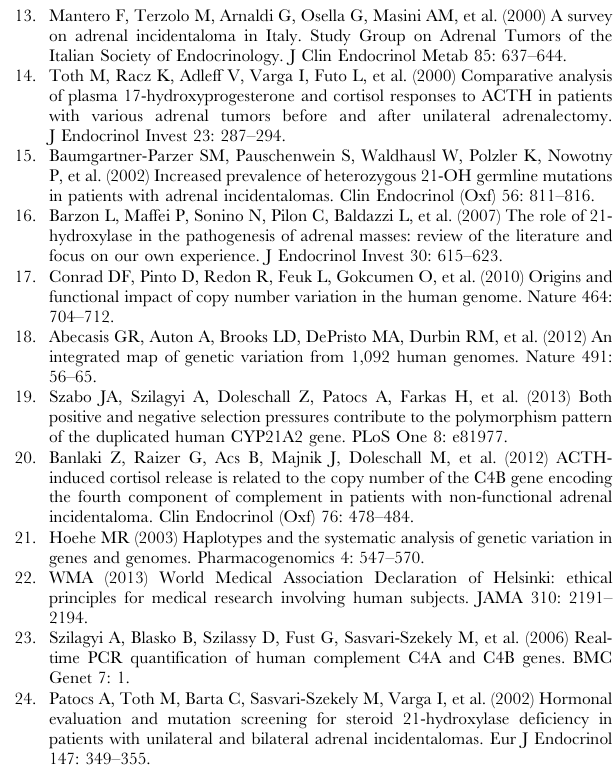
Figure S1 Linkage disequilibrium (LD) map of dimor- phic polymorphisms along the intron 2 and the 5 9 -end of exon 3 of the CYP21A2 gene in subjects with non- functional adrenal incidentaloma. The polymorphisms are numbered from the start of the CYP21A2 coding region in the sequence of NT_007592.15: 31945792–31949720, dbSNP ID are also represented. LD values are expressed in r 2 , and darker background color indicates higher LD. Polymorphism 605 (rs6451) is not represented because this visualization can handle only dimorphic polymorphisms. Some previously described polymorphisms were absent in the current dataset because their minor alleles are rare or occur only in the haplotypes which were excluded due to the harbored congenital adrenal hyperplasia mutations. Table S1 Haplotypes of CYP21A2 intron 2 and the 5 9 -end of exon 3. CYP21A2 - steroid 21-hydroxylase gene, NFAI - non- functional adrenal incidentaloma. Table S2 Statistical significances (p-values) between hormone levels of the genotypes of discrete CYP21A2 intron 2 polymorphisms in subjects with non-functional adrenal incidentaloma. ACTH – adrenocorticotrophic hor- mone. Statistical significances of t-tests, Mann-Whitney tests, ANOVAs and Kruskal-Wallis tests were investigated in discrete CYP21A2 intron 2 polymorphisms which were not in complete linkage disequilibrium with each other, and had minor alleles occurring in more than four subjects. Genotype groups which did not exceed 4 individuals were also not taken into account. Significant p values are followed by the values of power. Statistical